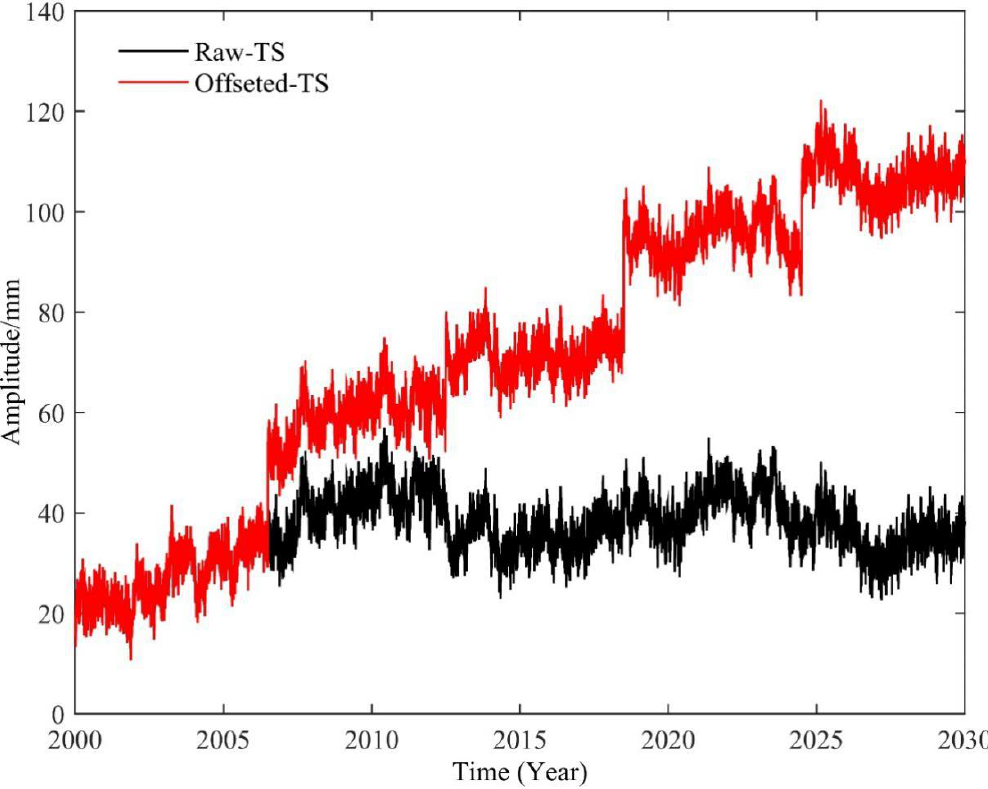
Figure 2. The result of TEST_1 after inserting an 18 mm (offset) step function in 4 epochs.